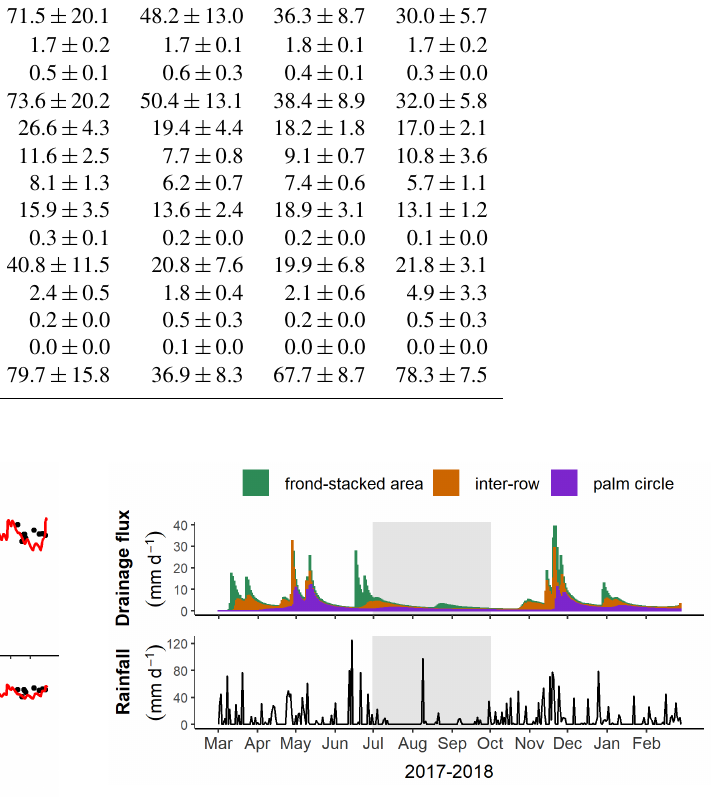
Figure 2. Monthly water drainage at 1.5m depth, simulated in each management zone, and daily rainfall from March 2017 to Febru- ary 2018. The gray shaded areas represent the dry season (precipi- tation less than 140mmmonth − 1